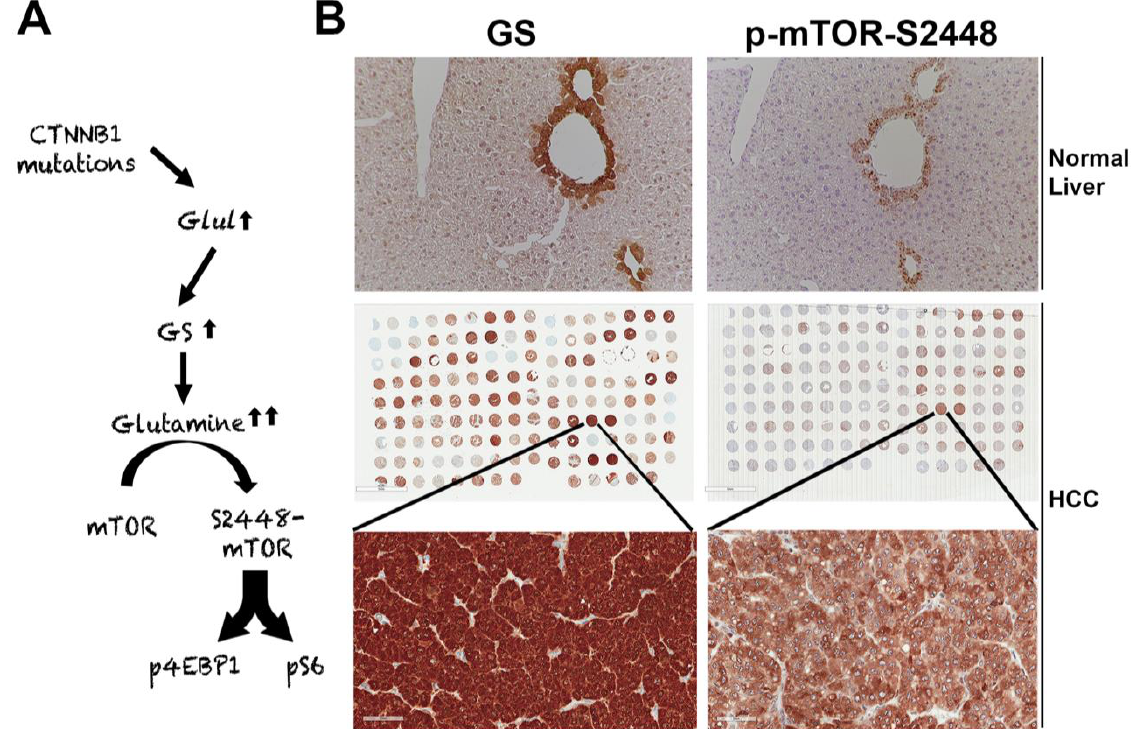
Figure 2. Unique mTORC1 addiction of CTNNB1 -mutated HCCs due to glutamine. ( A ) The unique axis of mTORC1 activation in β -catenin gene mutated HCCs due to overexpression of GLUL, the gene encoding for glutamine synthetase (GS), which generates glutamine from ammonia and glutamate, and in turn glutamine activates mTORC1 in lysosomes. ( B ) The top panel shows immunohistochemistry for GS and p-mTOR-S2448 in adjacent sections from a normal mouse liver. Both proteins are localizing exclusively to zone-3 hepatocytes in the immediate proximity to the central vein (200×). The whole slide scans (middle row) of two adjacent tissue microarrays of human HCC samples stained for the same antibodies against GS and p-mTOR-S2448 also shows several HCCs to be simultaneously positive for GS and p-mTOR-S2448. A representative tissue array sample is magnified (400×) to show GS and p-mTOR-S2448-positive HCC (bottom panels).